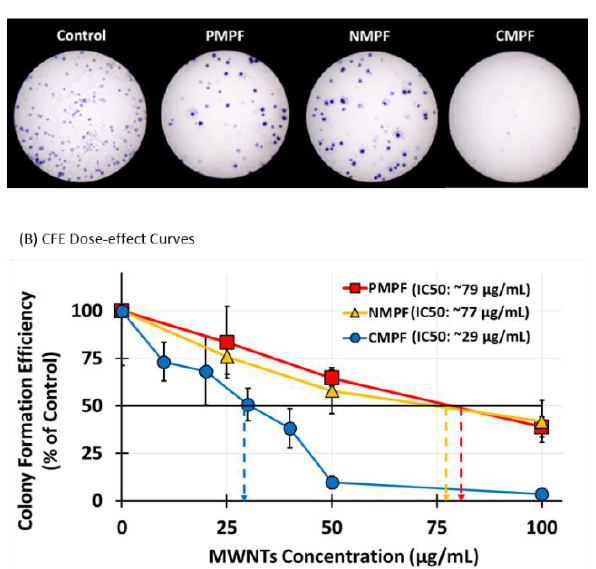
Figure 4. Colony formation efficiency (CFE) of RAW 264.7 cells after 8d of continuous exposure to P-, N-, or C-MWNTs at various concentrations up to 100 µg/mL. 300 RAW 264.7 cells were seeded in 35 mm culture plates with media containing various concentrations of P-, N-, or C-MWNTs up to 100 µg/mL and incubated at 37 °C in a 5% CO 2 incubator without disturbance for 8 day, then stained as described in Methods. CFE was defined as the ratio of the colony count over the seeded cell count in a plate. The concentration of MWNTs required to inhibit CFE by 50% (IC50) value was estimated from a linear regression dose-effect trend line. ( A ) Representative images of stained colonies in plates with control or cells treated with 100 µg/mL of P-, N-, or C-MWNTs. ( B ) CFE of RAW 264.7 cells incubated in media containing P-, N-, or C-MWNTs for 8 day at 37 °C, relative to untreated control where the CFE was set to 100%. Dotted arrows indicate estimated IC50 values. Data are the average of 6 replicate plates per sample in ≥3 independent experiments ± SD.